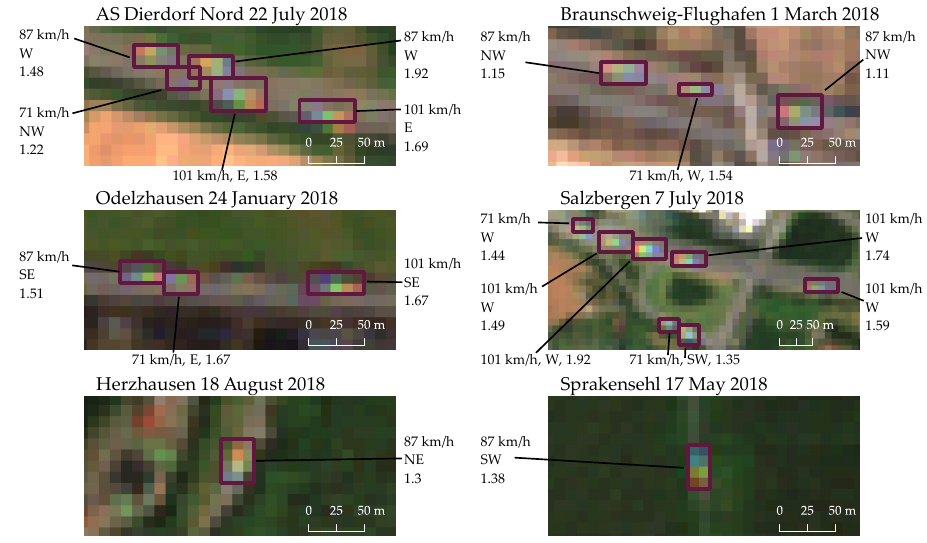
Figure 15. Visual detection examples at six validation stations with calculated speed, heading and detection score; bottom center and right are on primary roads, others on highways.